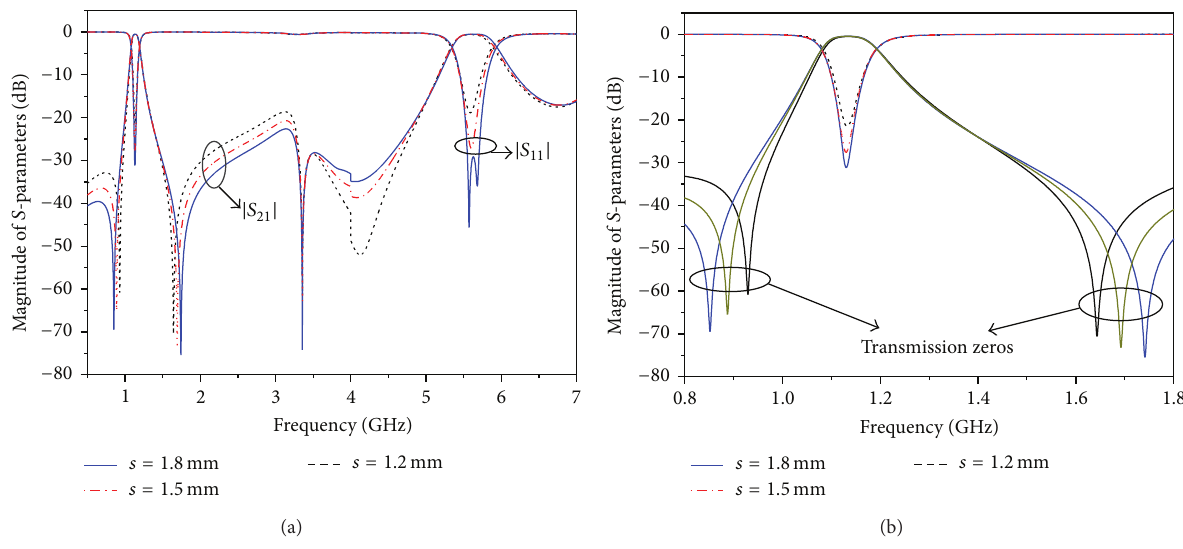
Figure 6: (a) Transmission characteristics and (b) location of transmission zeros.